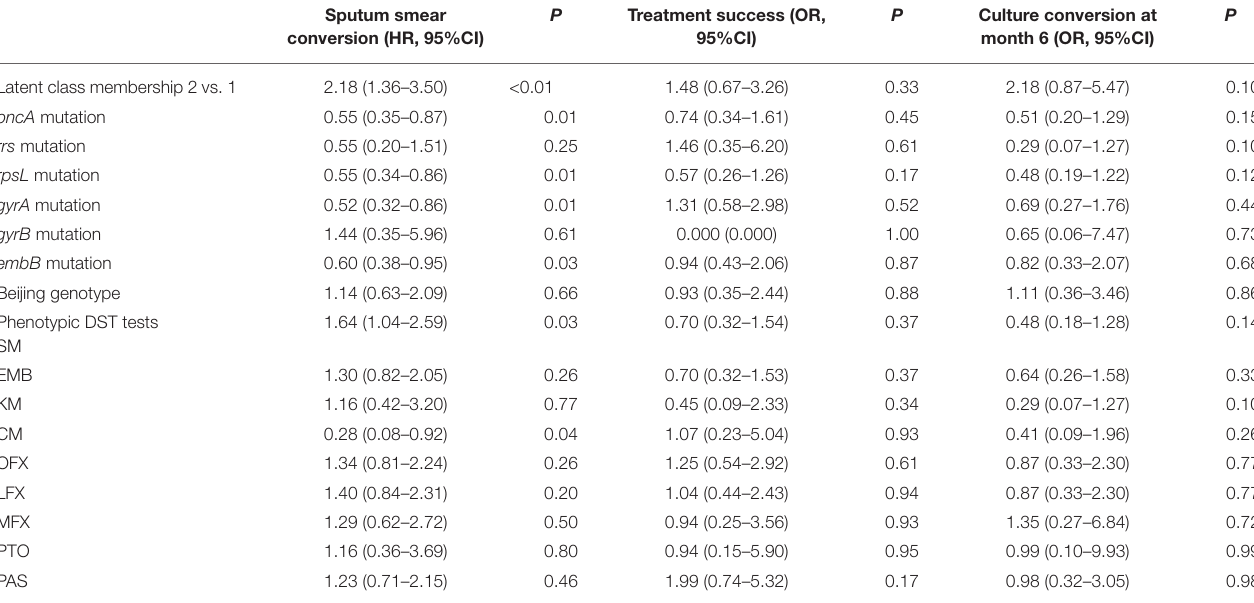
TABLE 2 | Univariate association between molecular/phenotypic drug susceptibility tests findings and clinical outcomes.